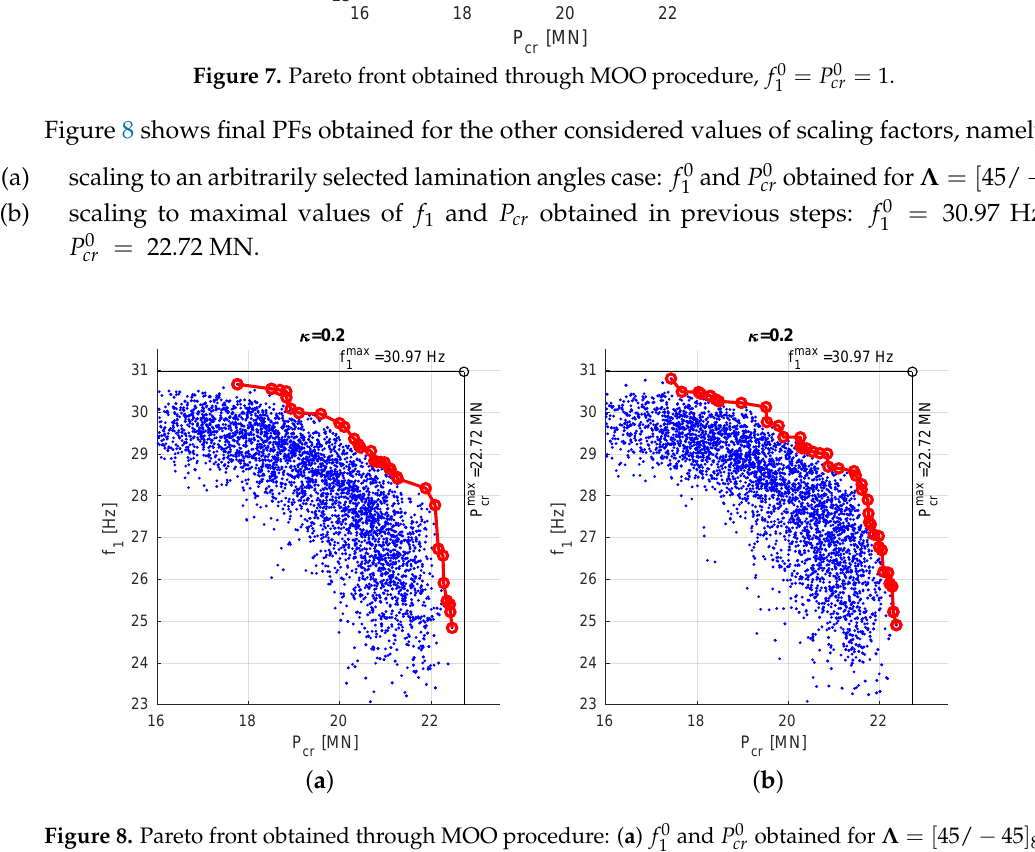
= 22.72 = P max cr cr